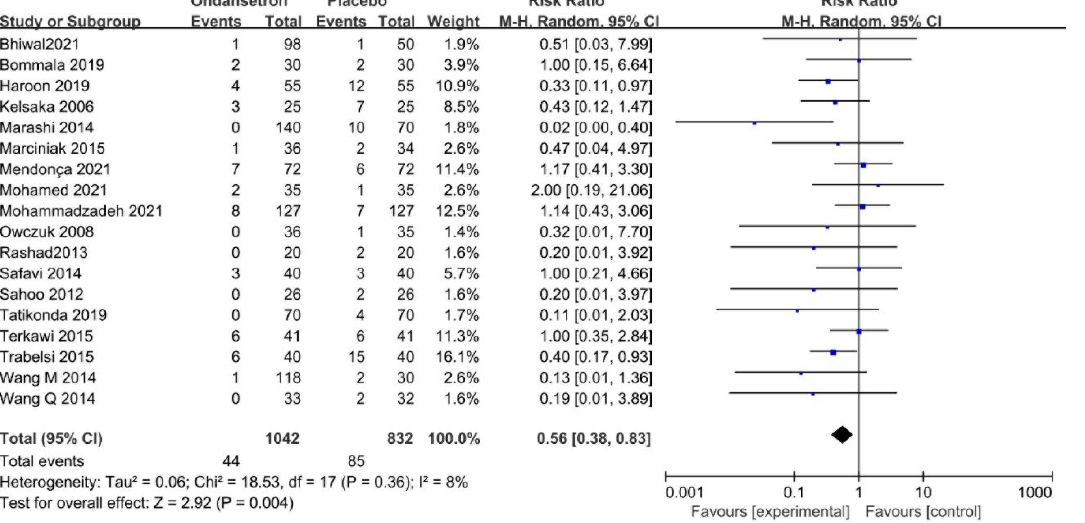
Figure 4. Forest plot of the pooled analysis showing the incidence of bradycardia.[2, 11-13, 30-33, 35, 38, 42-44, 46-50]